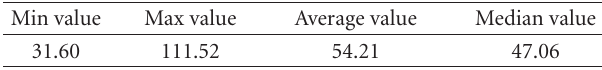
Table 5: Transcoding data rate